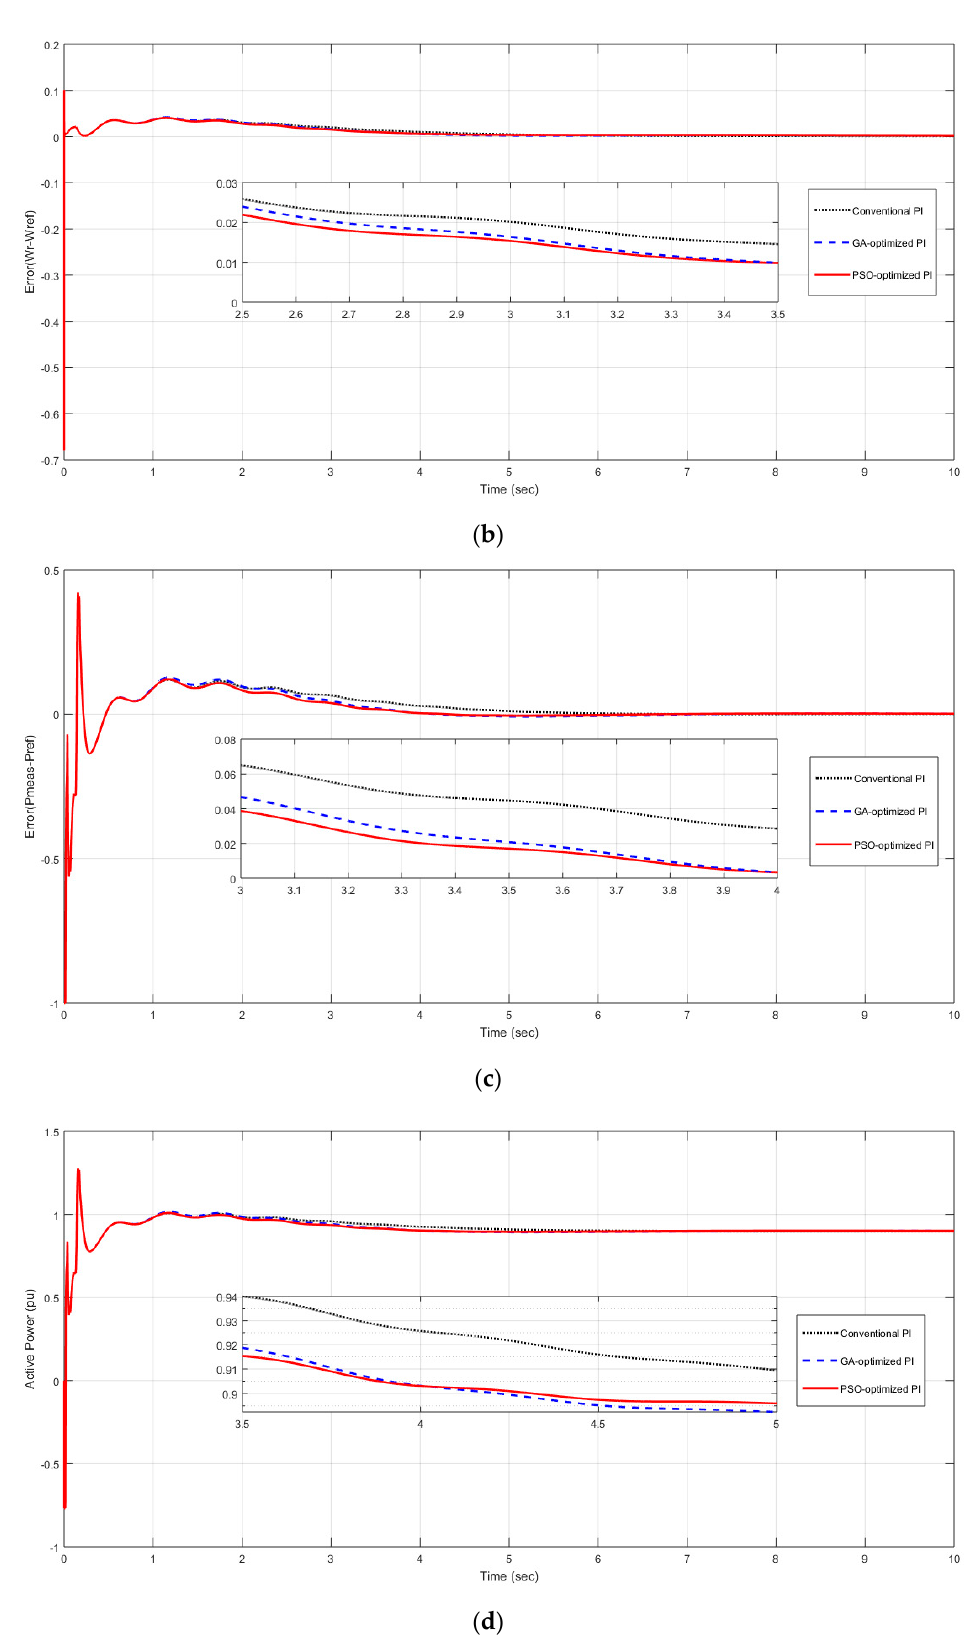
Figure 7. System response in Case 2: ( a ) pitch angle in degrees; ( b ) change in generator speed; ( c ) change in active power; ( d ) output power.